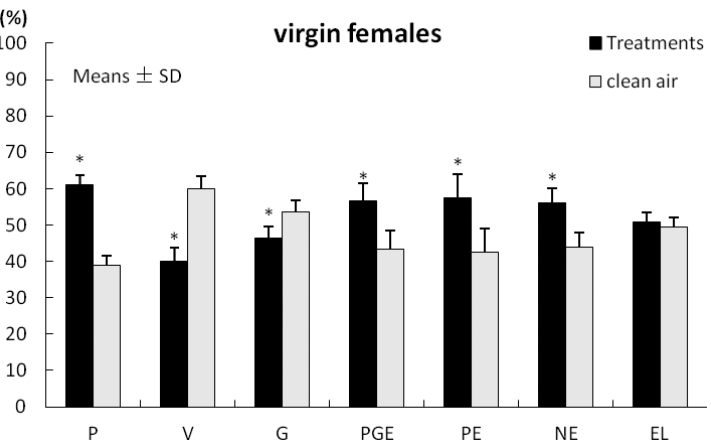
Figure 3. Trend rates of virgin females of Cephalcia chuxiongica to volatiles in one-way choice tests. P one pine shoot V one virgin female G one gravid female PGE one pine shoot with one female and her fresh eggs on the needles PE one pine shoot with fresh eggs but no female NE needles’ extract EL eggs’ eluent. *Indicates a statistically significant difference ( P < 0.05) between the trend rates of the virgin females to the odor and to clean air (nonparametric Wilcoxon matched pairs test, twotailed).